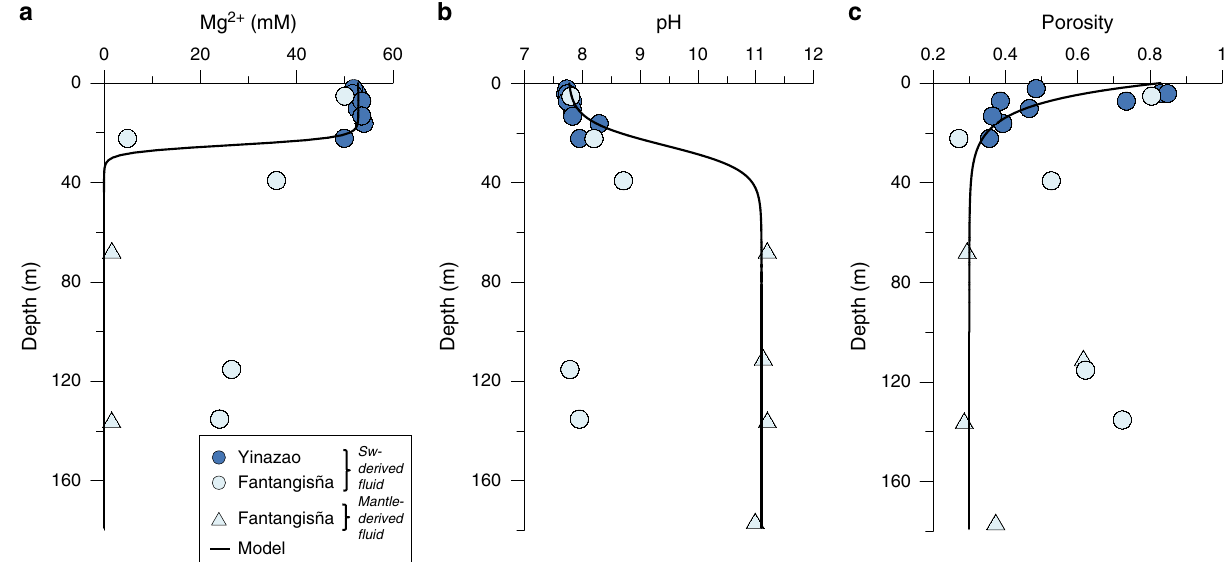
Fig. 3 Depth-pro fi les characterizing the layering of the seamount fl uid system. a Mg 2 + concentrations in pore fl uids, ( b ) pH values, ( c ) sediment porosity. Functions were fi tted through the data to generate continuous depth pro fi les for the transport-reaction modeling (Supplementary Methods). Mg 2 + and porosity data are reported in Fryer et al. 28